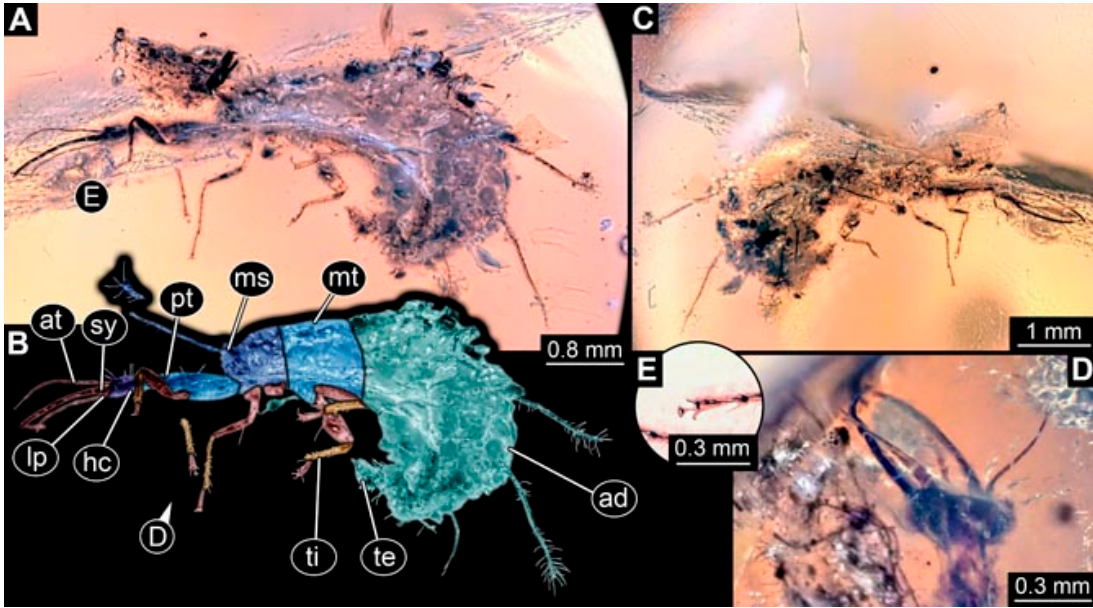
Figure 45. Specimen 4875 (PED 1335); Myanmar amber. ( A ) Lateral view from left side. ( B ) Lateral view from left side, colour-marked. ( C ) Lateral view from right side. ( D ) Close-up of head capsule in dorsal view. ( E ) Close-up of distal end of trunk appendage. Abbreviations: ad = abdomen; at = antenna; hc = head capsule; lp = labial palp; ms = mesothorax; mt = metathorax; pt = prothorax; sy = stylet; te = trunk end; ti =